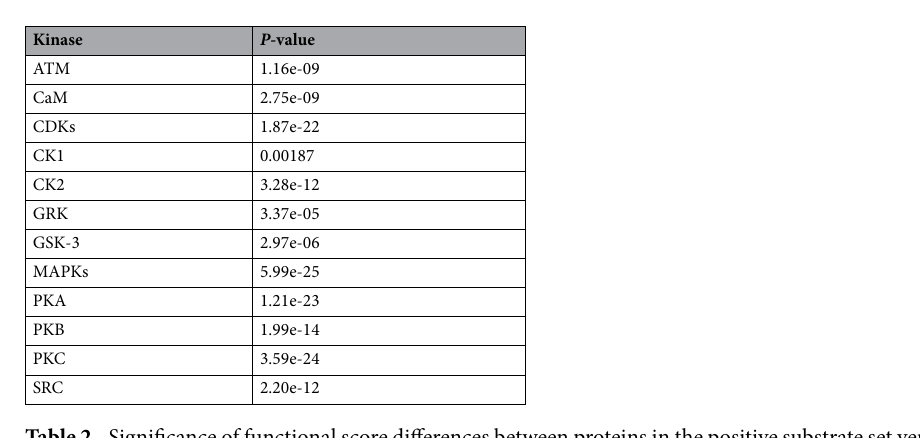
Table 2. Significance of functional score differences between proteins in the positive substrate set versus the background set, estimated by statistical t